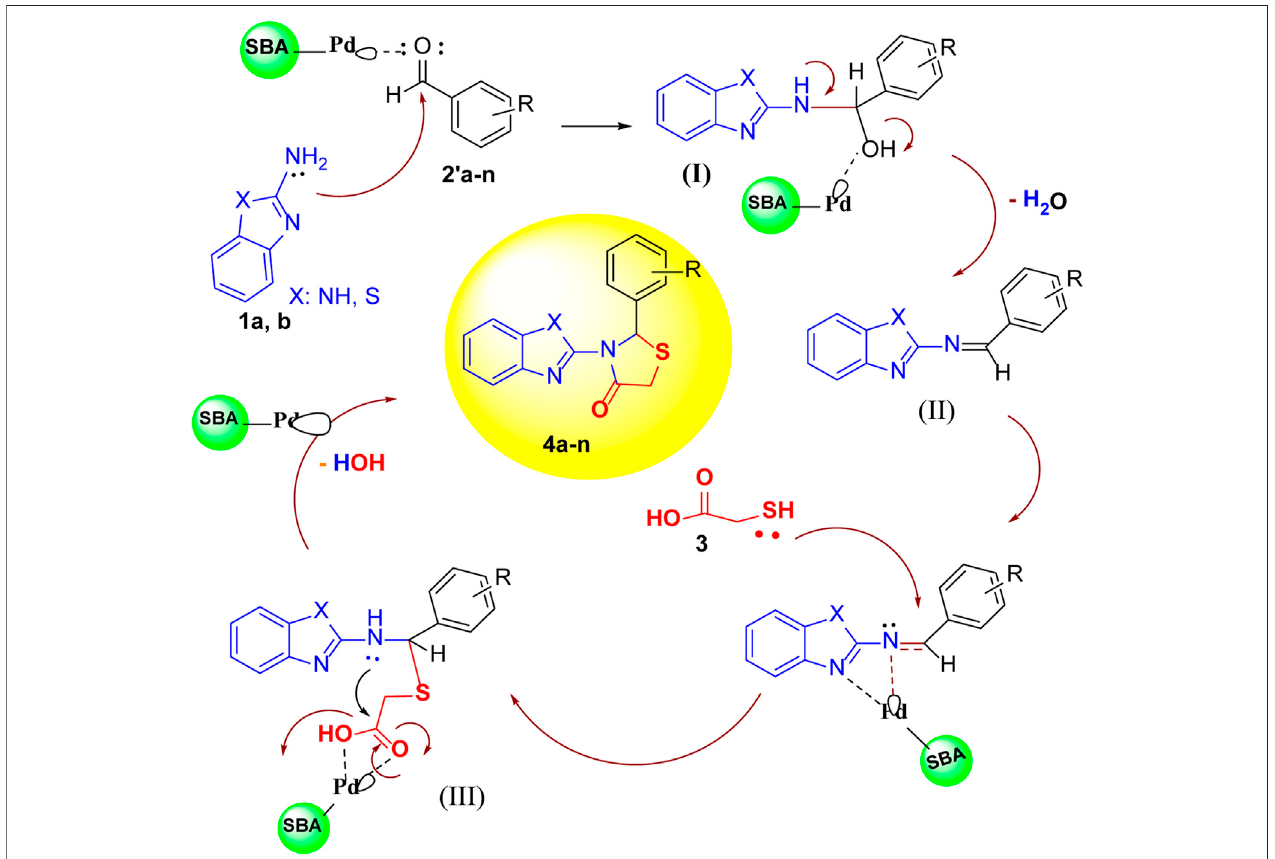
Figure 2C , the particle size is in the range of 21 – 24 nm. The TEM micrographs in Figure 2C illustrate regular mesoporous channels of silica after modi fi